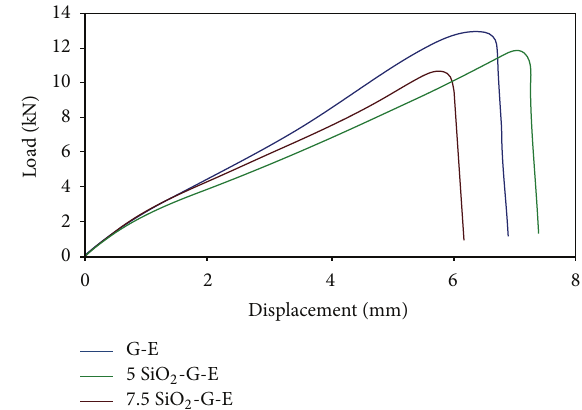
Figure 5: Tensile strength of SiO 2 filled G-E composites.